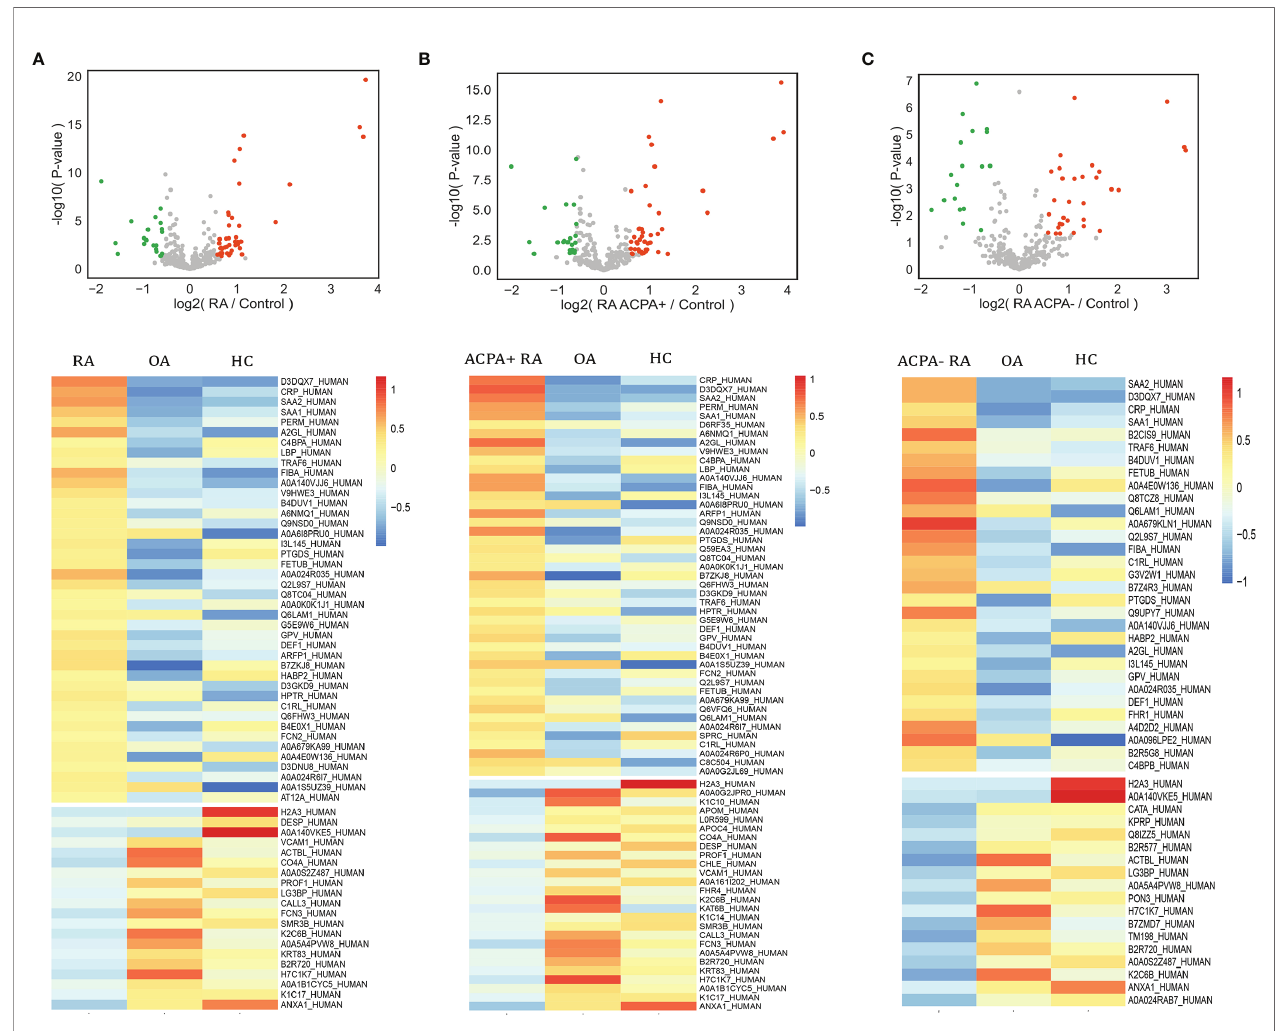
FIGURE 3 | Analysis of differential expressed proteins. Volcano plots compare RA (A) , ACPA-positive RA (B) , ACPA-negative RA (C) , and controls. Heatmap analysis of proteins that differ signi fi cantly ( p < 0.05, fold change > 1.5) in abundance in RA (A) , ACPA-positive RA (B) , and ACPA-negative RA (C)